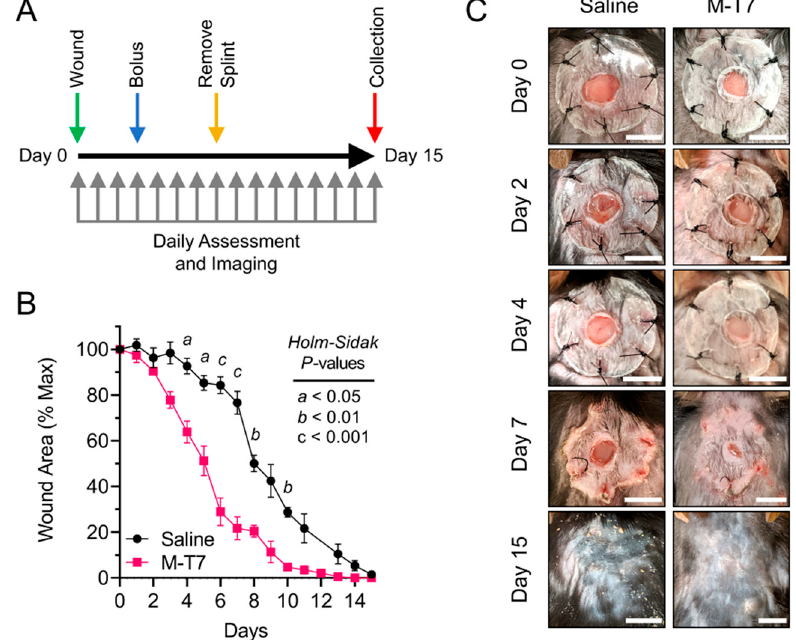
Figure 1. M-T7 accelerates full-thickness wound healing in mice. ( A ) Experimental design overview. Mice were wounded on day 0 (green arrow) and followed to day 15 post-wounding (red arrow), at which time mice were euthanized and tissue was collected. Mice were treated with saline or M-T7 on day 0 with a second bolus give on day 3 post-wounding (blue arrow). Mice were anesthetized and splints were removed on day 7 post-wounding (yellow arrow). Mice were assessed daily and images were collected for planimetric measurement of wound closure (gray arrows). N = 5 in each group. ( B ) Planimetric measurements of wound closure normalized to day 0 for each mouse. Mean and standard error are shown. Statistics were calculated by T -test per-day with correction for multiple comparisons by the Holm–Sidak method. For significance, a equates to p < 0.05, b equates to p < 0.01 and c equates to p < 0.001. ( C ) Representative wound images for saline and M-T7-treated mice on the day of wounding (day 0) and on days 2, 4, 7 and 15 post-wounding. The same mouse is shown in each image per condition. Scale bars are 5 mm.